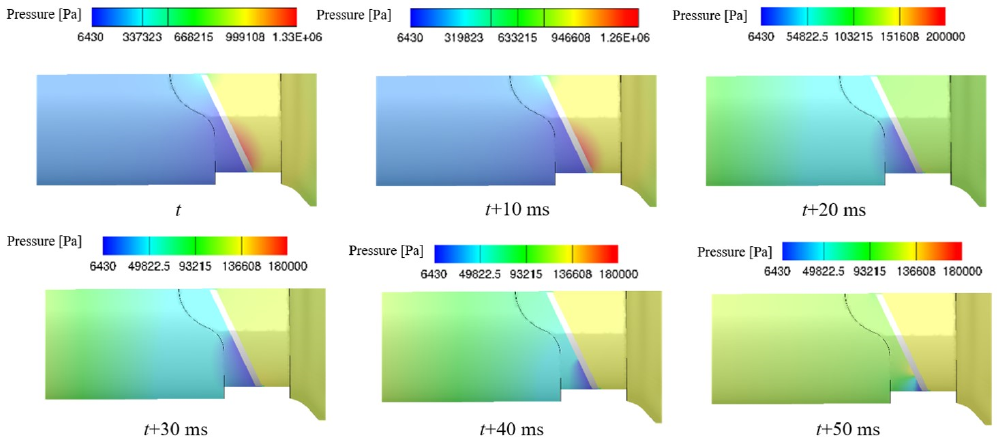
Figure 10. The pressure distributions after valve closing.